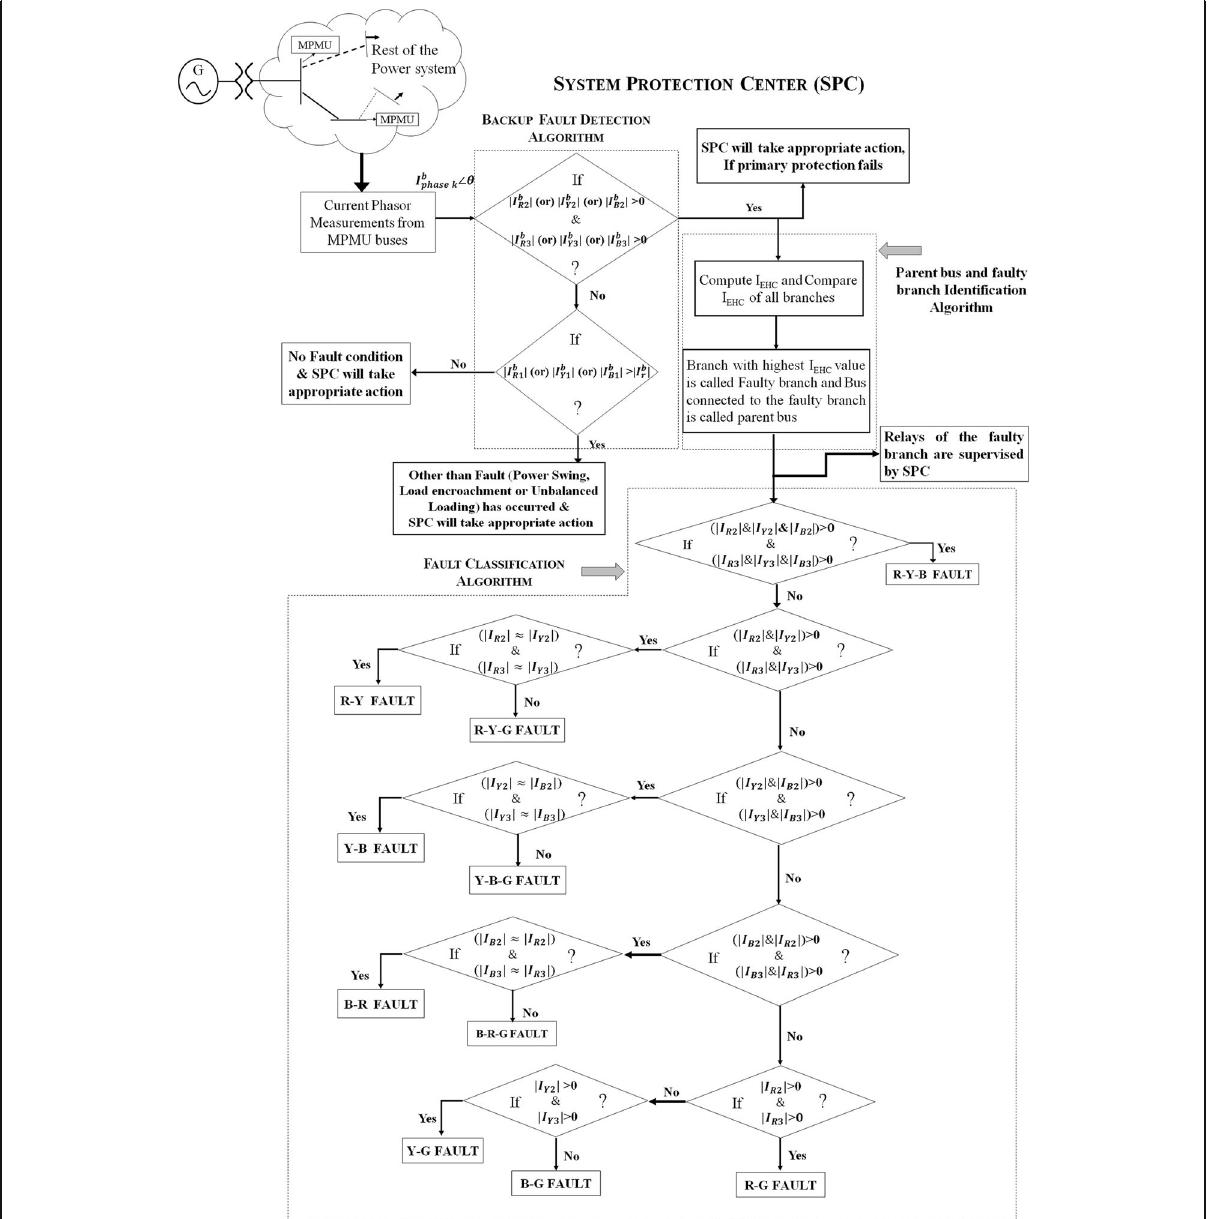
Fig. 3 Sequence of execution of proposed ASWABP Scheme at